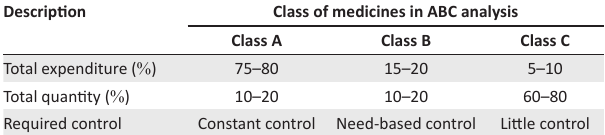
TABLE 1: Explanation of the three different categories in ABC analysis. 12